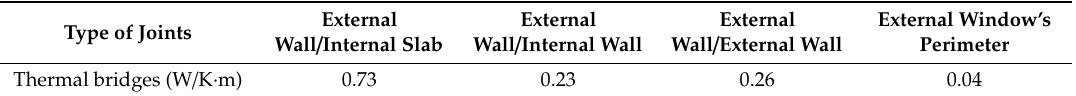
Table 4. The linear heat loss coe ffi cient for thermal bridges (W / K · m) for di ff erent types of joints in the building.